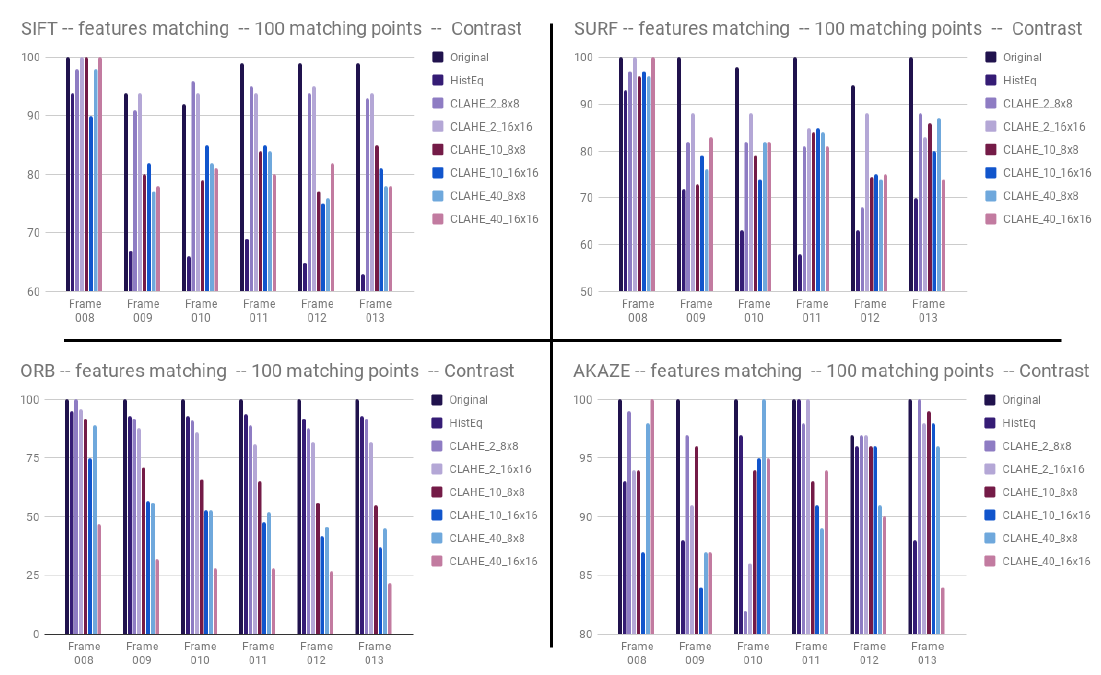
Figure 15. Inliers percentage depending on frame number and contrast method using. SIFT, SURF, ORB and AKAZE. Table 2. KPI (%) given by PD algorithm after contrast enhancement using CLAHE filters (CLAHE 2_8: